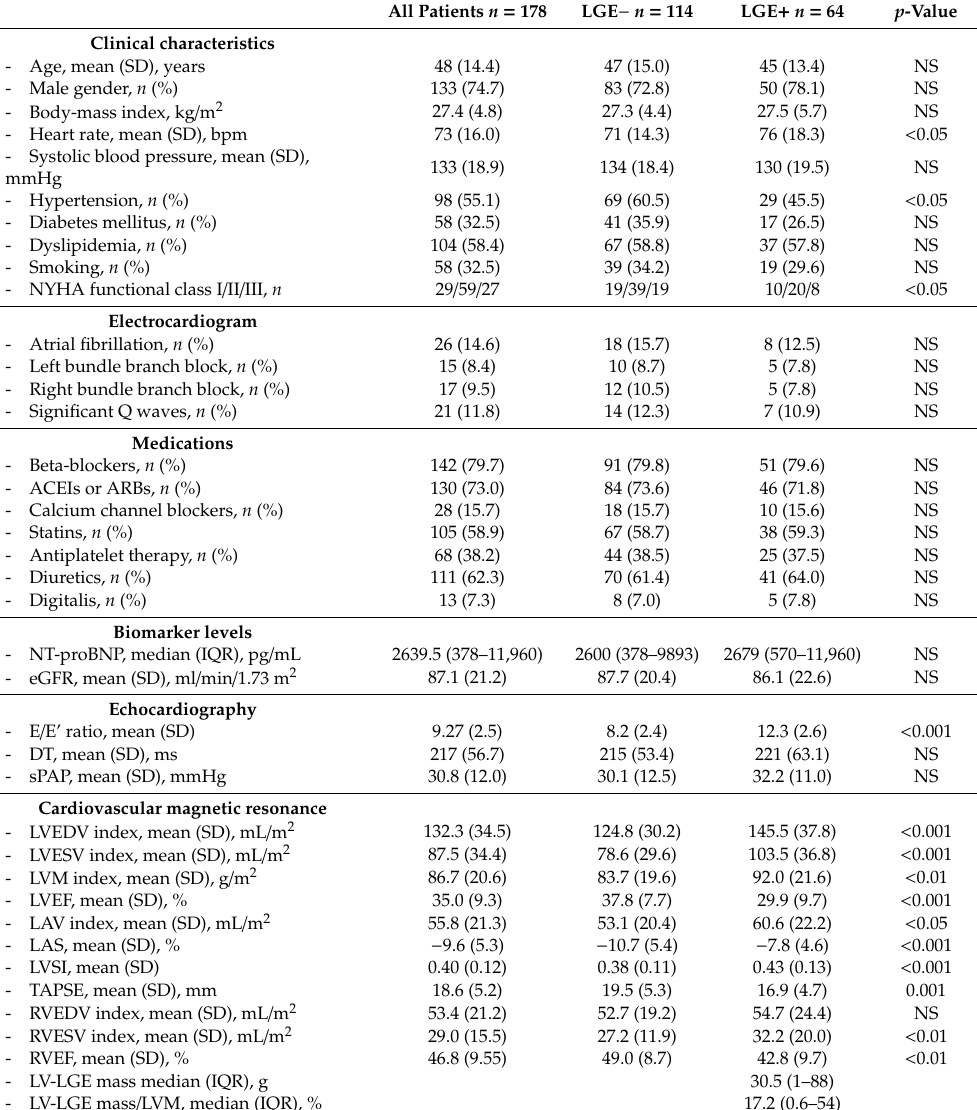
Table 1. Baseline characteristics of patients in